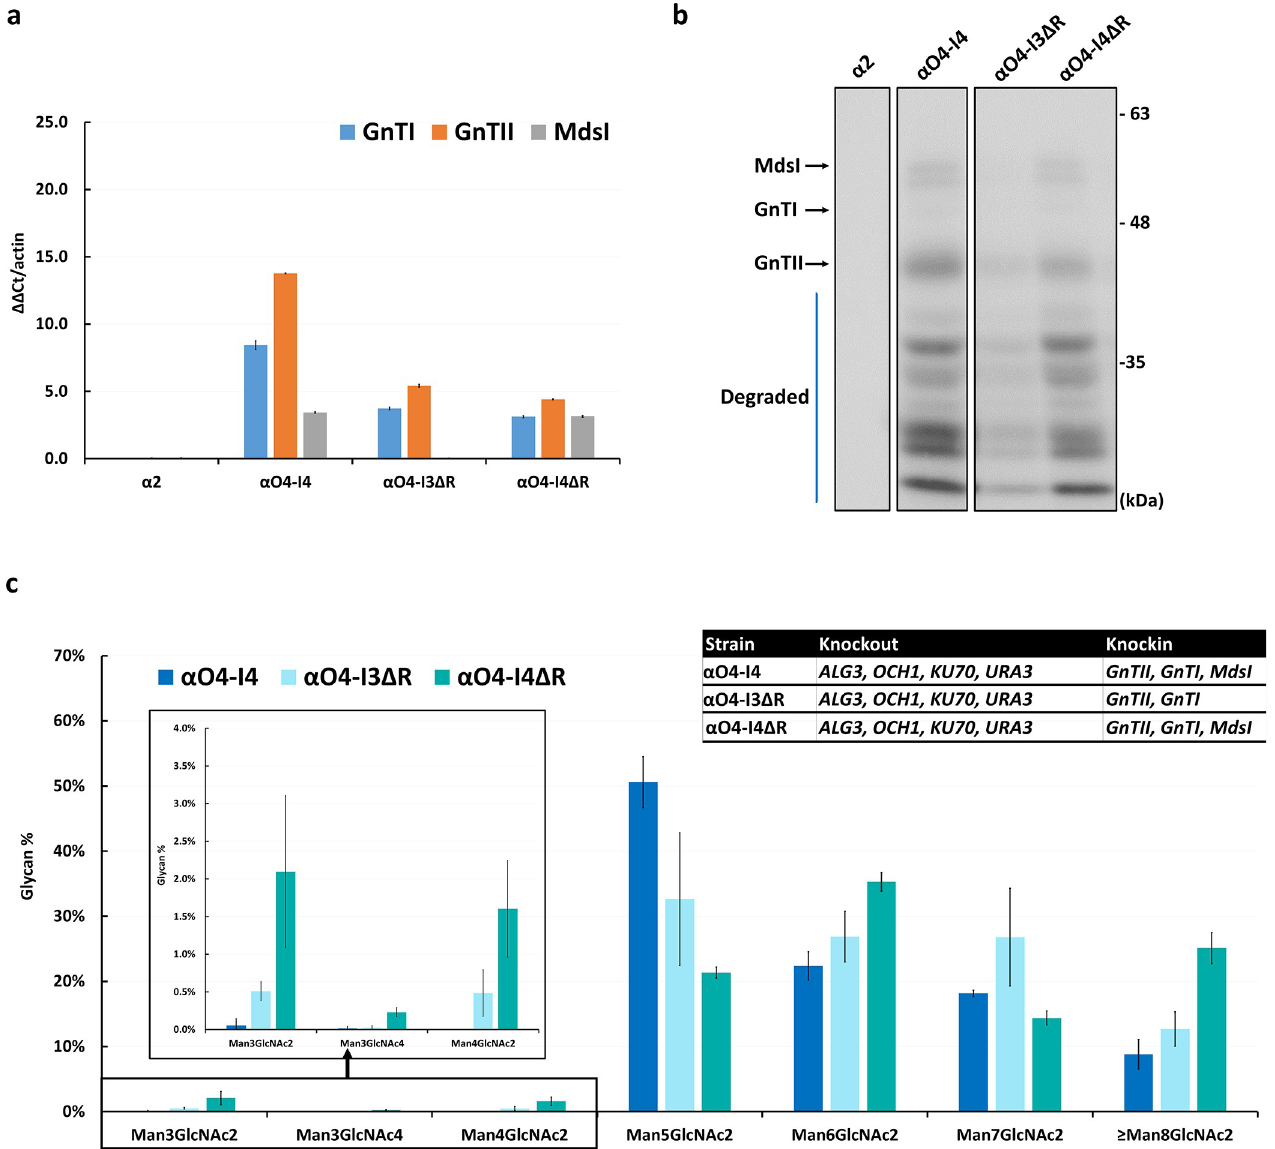
Fig 5. Analyses of RNA expression level, protein expression level and N-glycan profile in K . marxianus α O4-I4, α O4-I3 Δ R and α O4-I4 Δ R. (a) The RNA expression levels of GnTI , GnTII , and MdsI . The qRT-PCR used the endogenous actin gene as the reference. (b) Western blot analysis of protein expression of MdsI , GnTI and GnTII . The arrows indicate the MdsI, GnTI, and GnTII proteins. The blue line indicates degraded proteins. (c) The glycan profiles in the four engineered strains. The zoom-in figure shows the profiles of Man 3 GlcNAc 2 , Man 3 GlcNAc 4 , and Man 4 GlcNAc 2 in the four strains. The number of replicates was 3 for each